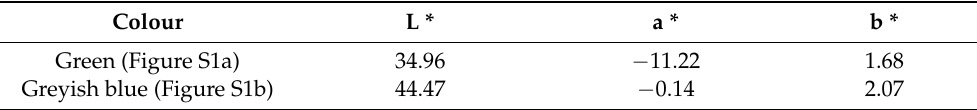
Table 2. Lab values of the colours measured in the samples in Figure S1. Colour L * a * b * Green (Figure S1a) 34.96 − 11.22 Greyish blue (Figure S1b)